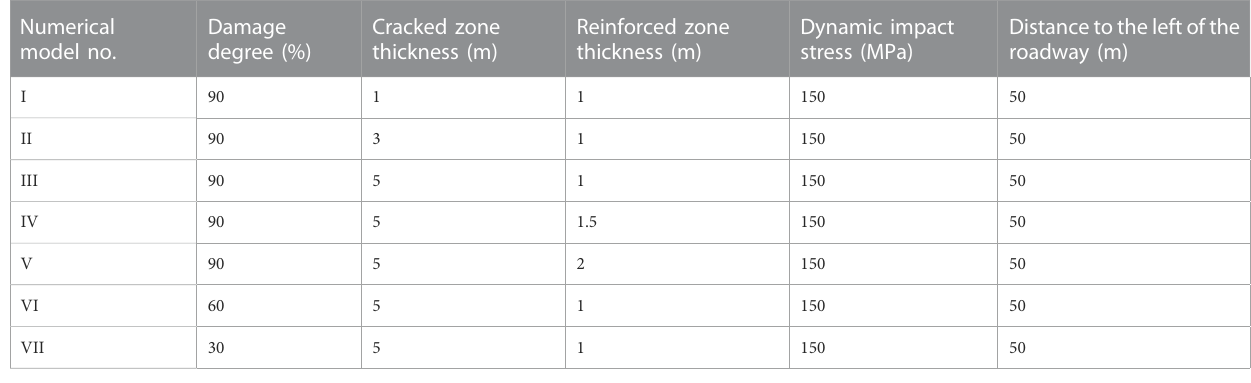
reinforced zone thicknesses was studied. As shown in Figure 10, dynamic stress-time curves of different reinforced zone thicknesses (1 m, 1.5 m, and 2 m) were seen. Under the conditions of the reinforced zone thickness of 1 m, 1.5 m, and 2 m, the dynamic peak stresses of monitoring points located at the inner wall of the roadway top were 8.18 MPa, 10.12 MPa, and 12.31 MPa, with a decrease of 87.9%, 85.2%, and 81.4%, respectively. For the monitoring points located at the inner wall of the roadway side, the dynamic peak stresses with reinforced zone thickness of 1 m, 1.5 m, and 2 m were 10.96 MPa, 11.81 MPa, and 12.51 MPa, which showed a decrease of 94.7%, 94.7%, and 94.3%. Simultaneously, at the bottom of the roadway, the reduction rates of dynamic peak stresses showed a decrease of 65.0%, 81.7%, and 87.9%, corresponding to the reinforced zone thickness of 1 m, 1.5 m, and 2 m, respectively. The results indicated that the in fl uence of the reinforced zone thickness on the method was not obvious if the cracked zone has a competent energy absorption capacity.